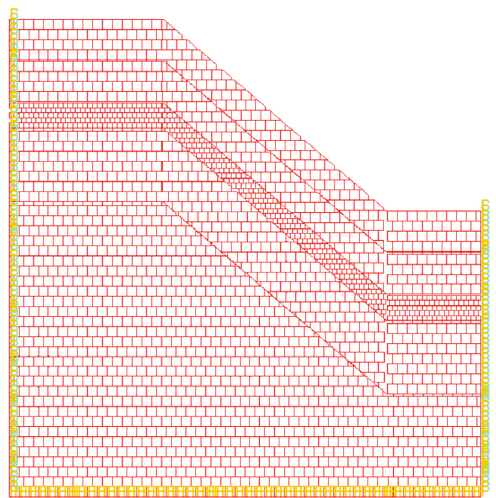
Figure 5: Simpli fi ed model of slope.